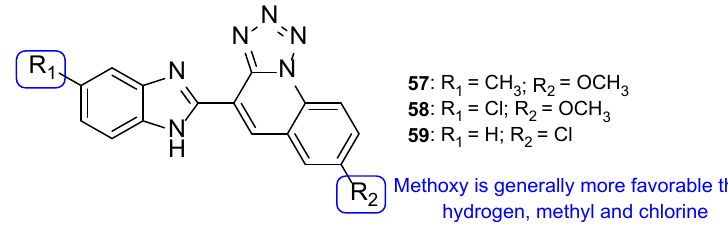
Figure 31. Chemical structures of compounds 57 – 59 and SAR regarding the R 2 substituents [111].